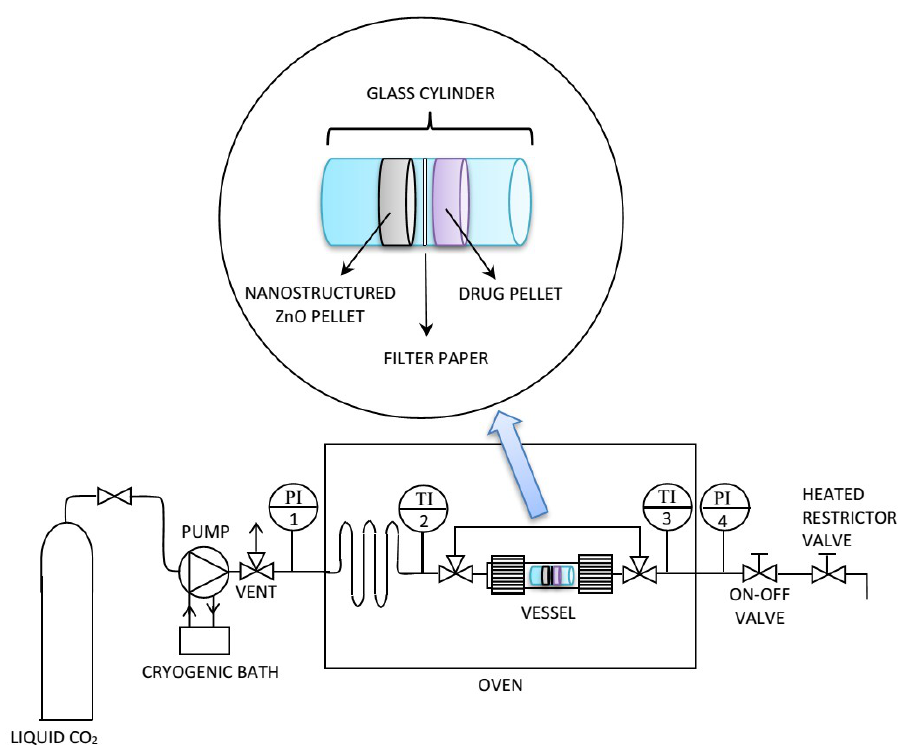
Figure 1. Experimental apparatus for supercritical carbon dioxide (scCO 2 )-mediated drug loading.